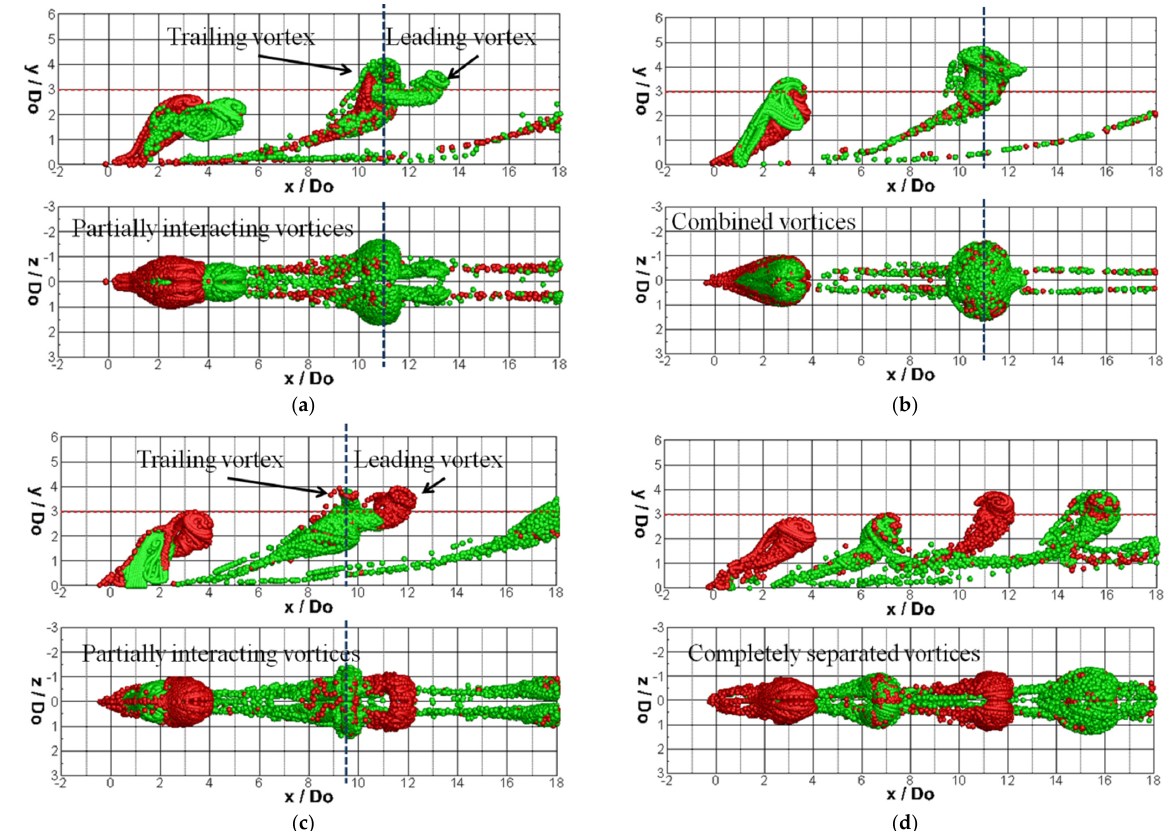
Figure 7. Colored fluid particles of the in-line twin SJs ( t / T = 0), ( a ) Δ ϕ = 0, ( b ) Δ ϕ = π / 2, ( c ) Δ ϕ = π , ( d ) Δ ϕ = 3 π / 2. ( d ) ∆ φ = 3 π /2.